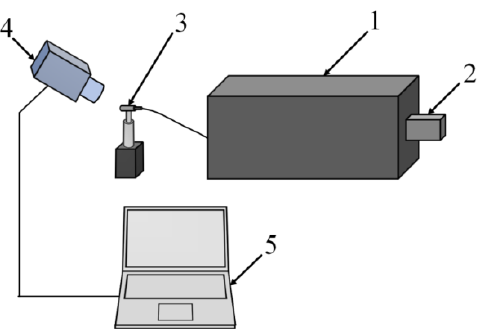
Figure 3. Scheme of hybrid experimental installation [41]: 1—spectrometer; 2—CCD; 3—fiber optic probe; 4—camera; 5—computer.